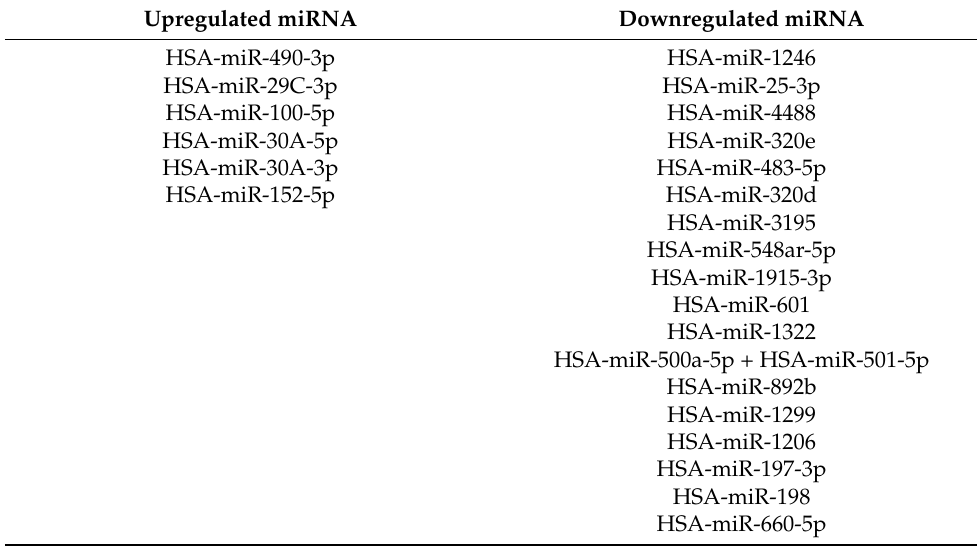
Table 4. miRNA significantly dysregulated in high versus low